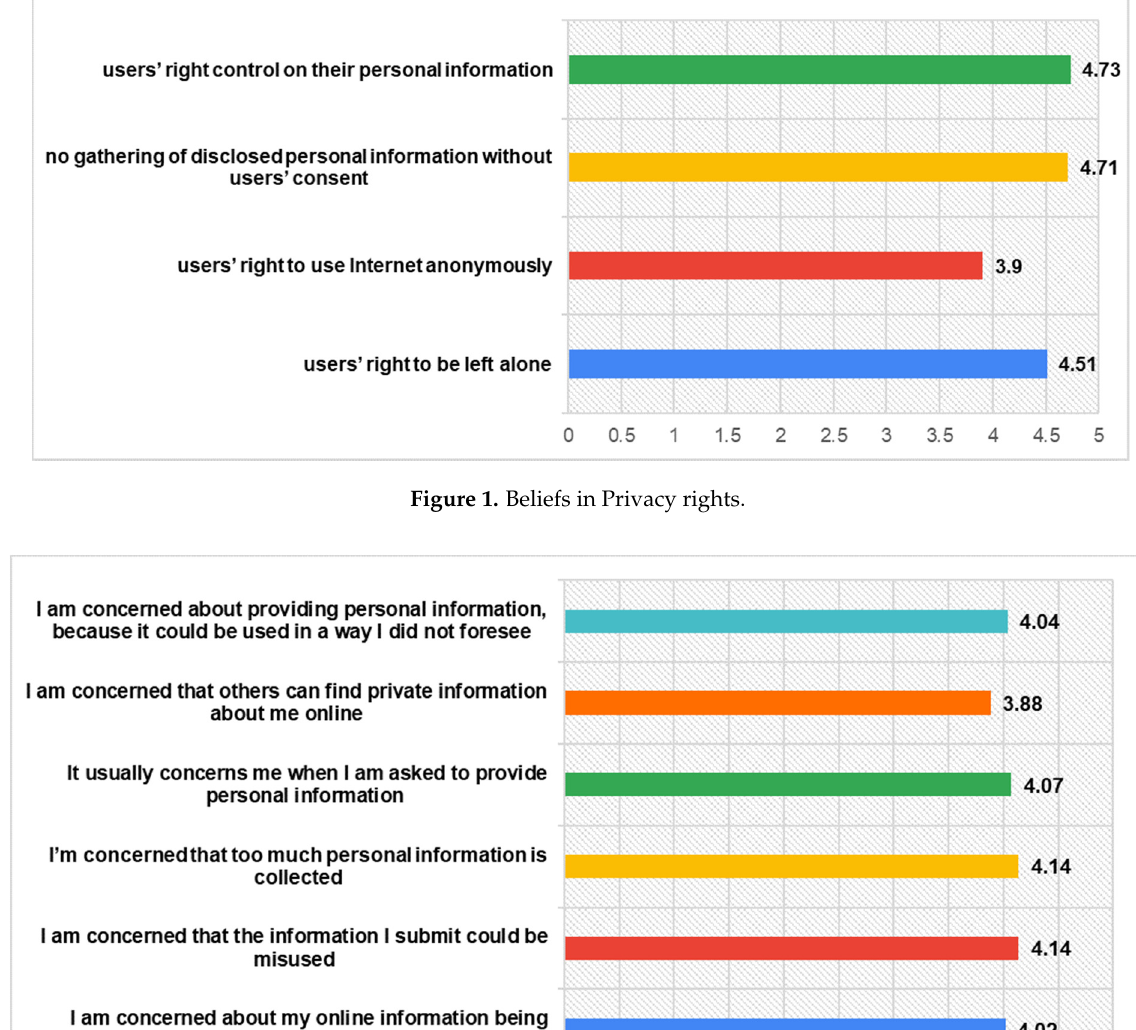
Figure 3. Self-disclosure.